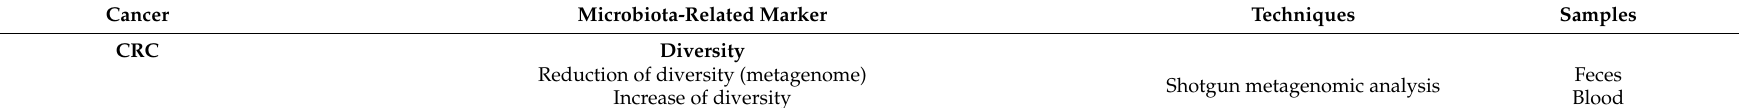
Table 1. Intestinal microbiota-related biomarkers for the screening of CRC, digestive cancers and other